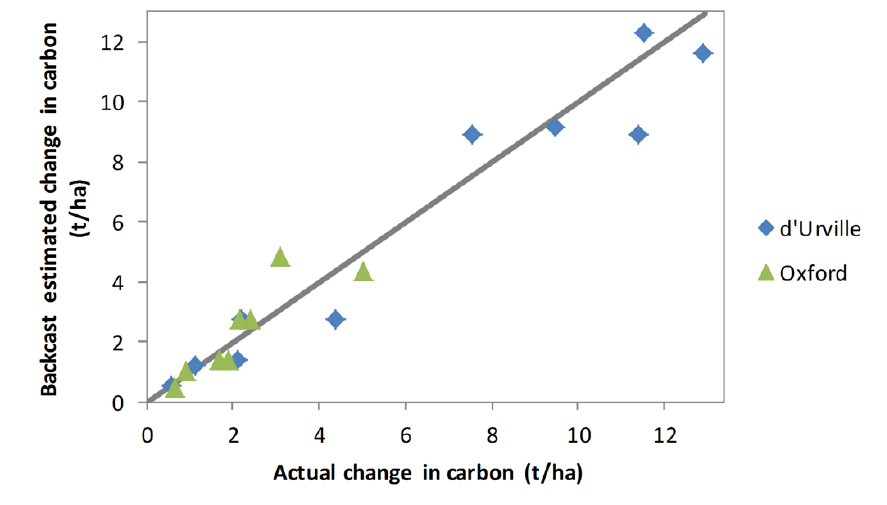
Figure 8. Backcast estimated 2008–2012 change in carbon versus actual change in carbon for plants measured for diameter and height in both 2008 and 2012. Values shown are plot means. The line indicates the y = x relationship.